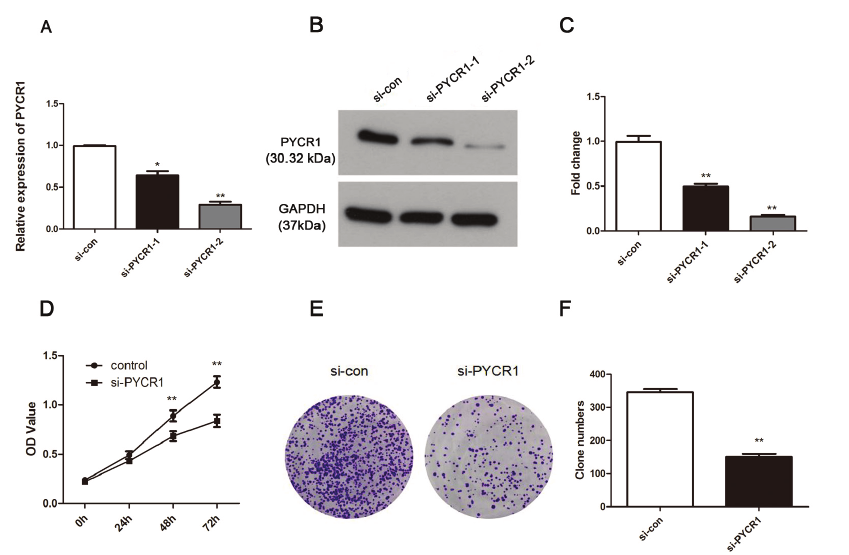
Figure 2: SiRNA strategy suppresses the PYCR1 expression successfully and retards cell viability in Ketr-3 cells. (A and B) The effective rates were detected by qRT-PCR analysis and western blot. (C) The fold change of western blot results. (D) Cell proliferation was measured using CCK-8 assay. (E) Colony formation was measured and (F) the number of clone was counted. The data are expressed as mean ± SD in triplica- tes. (*P < 0.05, **P <